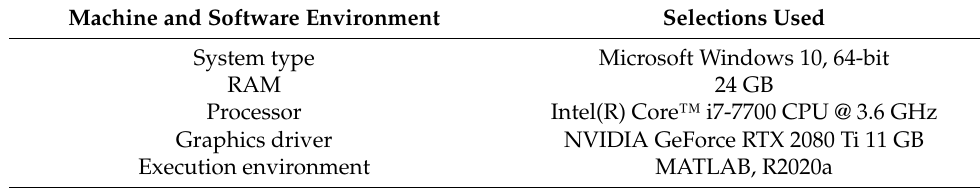
Table 3. Machine and software environment implemented in the training